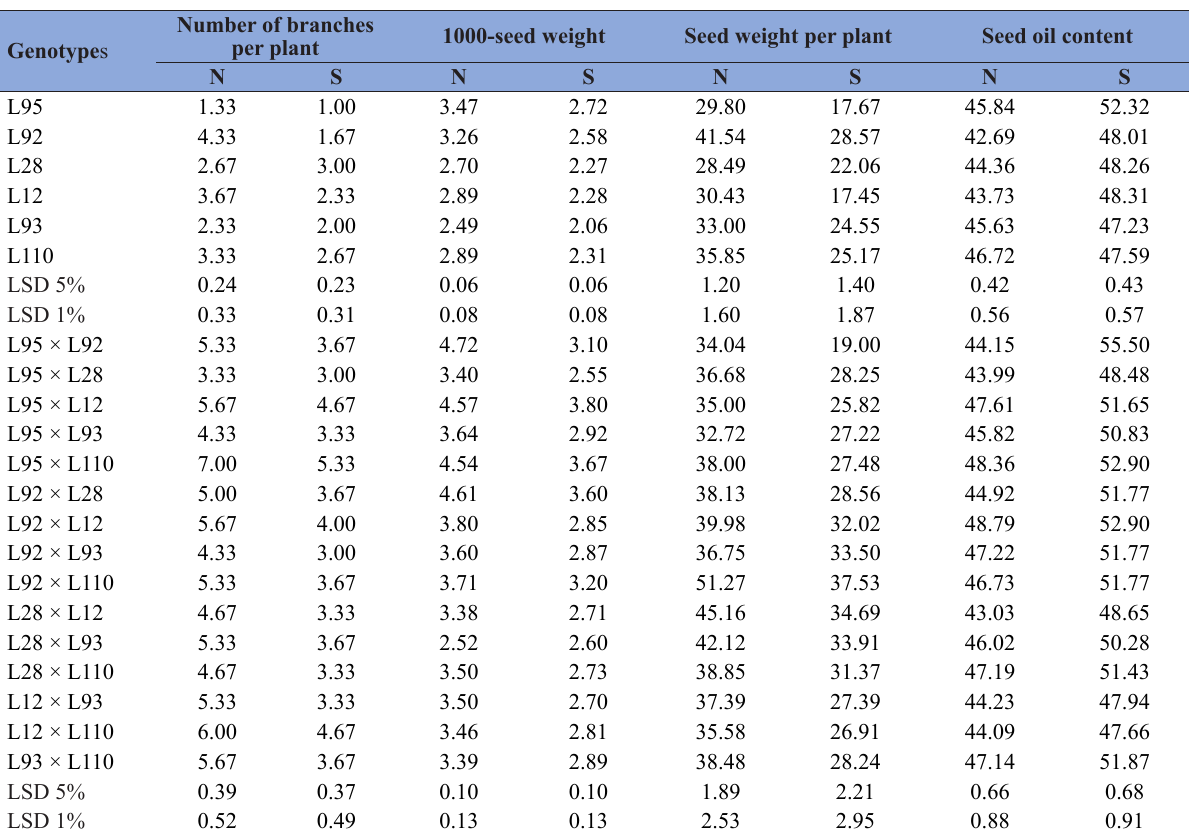
Table 5b. Mean performance of six parental sesame genotypes and their 15 F 1000-seed weight, seed weight per plant and seed oil content under normal irrigation (N) and water stress conditions (S) in 2019